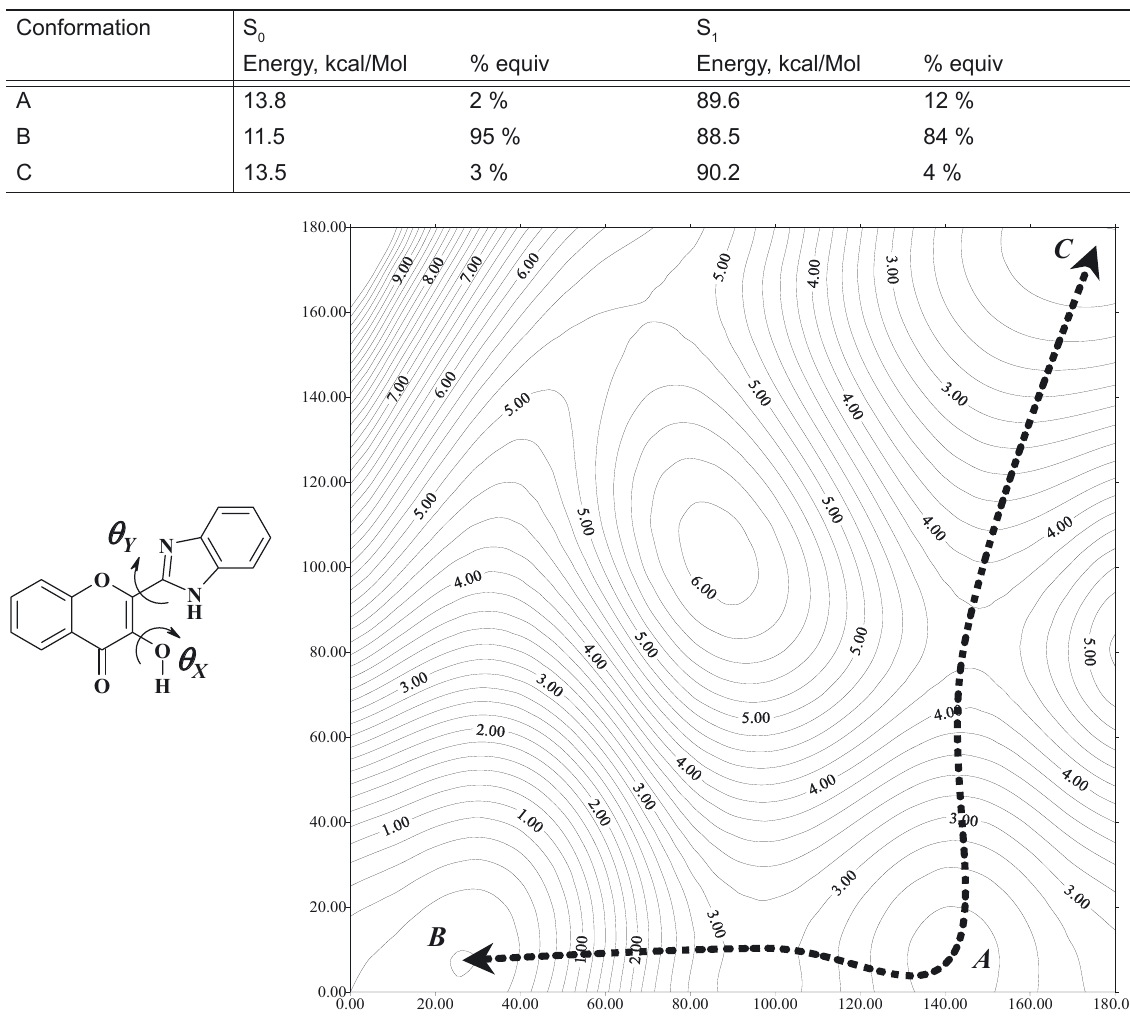
Figure 5. Potential energy surface ( DD H